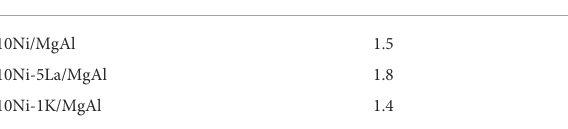
TABLE 1 The ratio of peak area between formate species and bicarbonate species in the steady state recorded from the in-situ